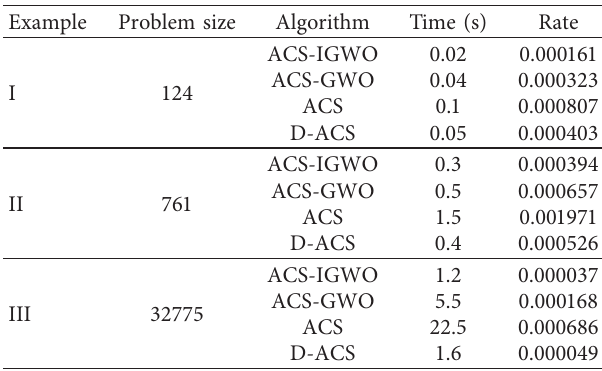
Table 15: Comparison of algorithms of different node cases.